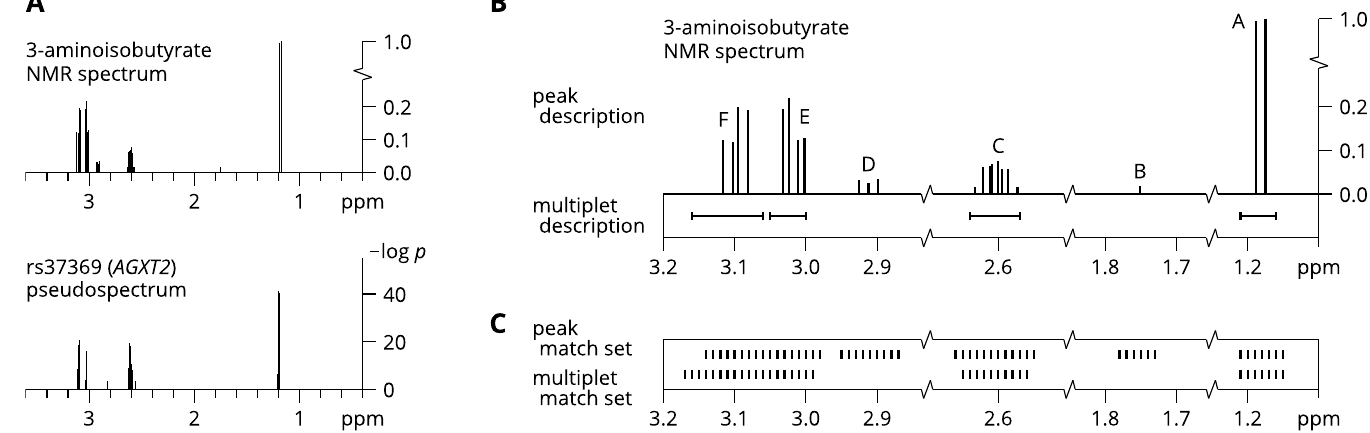
Fig 1. AGXT2 pseudospectrum and 3-aminoisobutyrate NMR spectrum, descriptions, and metabomatching match sets. (A) The upper plot shows the experimental NMR spectrum of 3-aminoisobutyrate. The lower plot shows the (-log) p -valuesof the pseudospectrum of rs37369in AGXT2 , when p < 10 − 3 . There is a close match betweenthe experimental spectrum and the pseudospectrum, as the four sets of features that associate ( p < 5 × 10 − 8 ) with rs37369correspondto the principalpeaks of the spectrum. (B) Taking a more detailedview of the spectrum descriptions (from HMDB), we see that the peaks of 3-aminoisobutyrategroup into six clusters (labeledA through F). The multipletranges for clusters A, C, and E enclosetheir correspondingpeaks well, paddingby an averageof 0.023 ppm. The multiplet range for cluster F is significantly wider, paddingby 0.062 ppm. Approximatingcluster areas as the product of the width of the cluster with the averageheightof the peaks in the cluster, then scaling, we find area-derived proton counts of 2.8, 0.7, 1.1, 1.2 for clusters A, C, E, and F, respectively.These counts are coherent with the listed proton counts of 3, 1, 1, and 1 for the respectivemultipletranges. Applyingthis same approximation for clusters B and D results in area-derived proton counts of 0.0, and 0.2. Because this impliescorrespondingmultipletproton counts of 0, we may considerthe two spectrum descriptions essentiallycoherent, even thoughno multiplet rangesare listed for clusters B and D. (C) Match sets obtainedfrom the peak and multipletdescriptionsof the 3-aminoisobutyratespectrum, for features resultingfrom a uniform NMR spectrum binningin 0.01 ppm increments, and with neighborhoodparameter δ = 0.03 and 0.01, respectively. While the peak and multipletdescriptions of the 3-aminoisobutyrate NMR spectrum may be essentiallycoherent, their resultingmatch sets do differ, with 22 features uniqueto either one of the match sets.